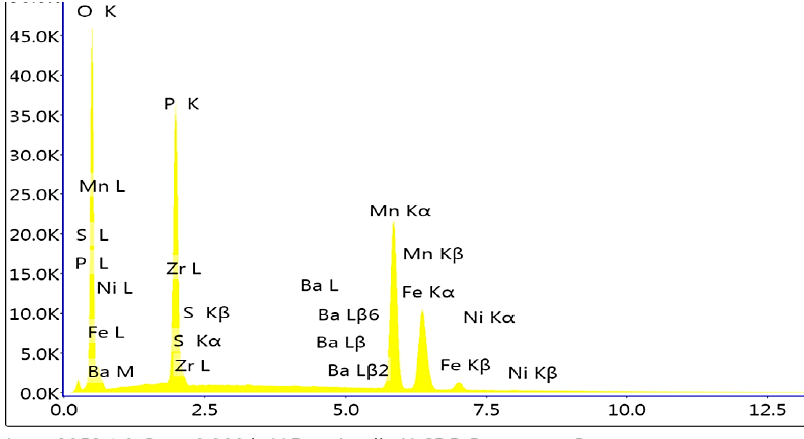
Figure 17. EDS analysis of a sample with a coating modified with barium nitrate.